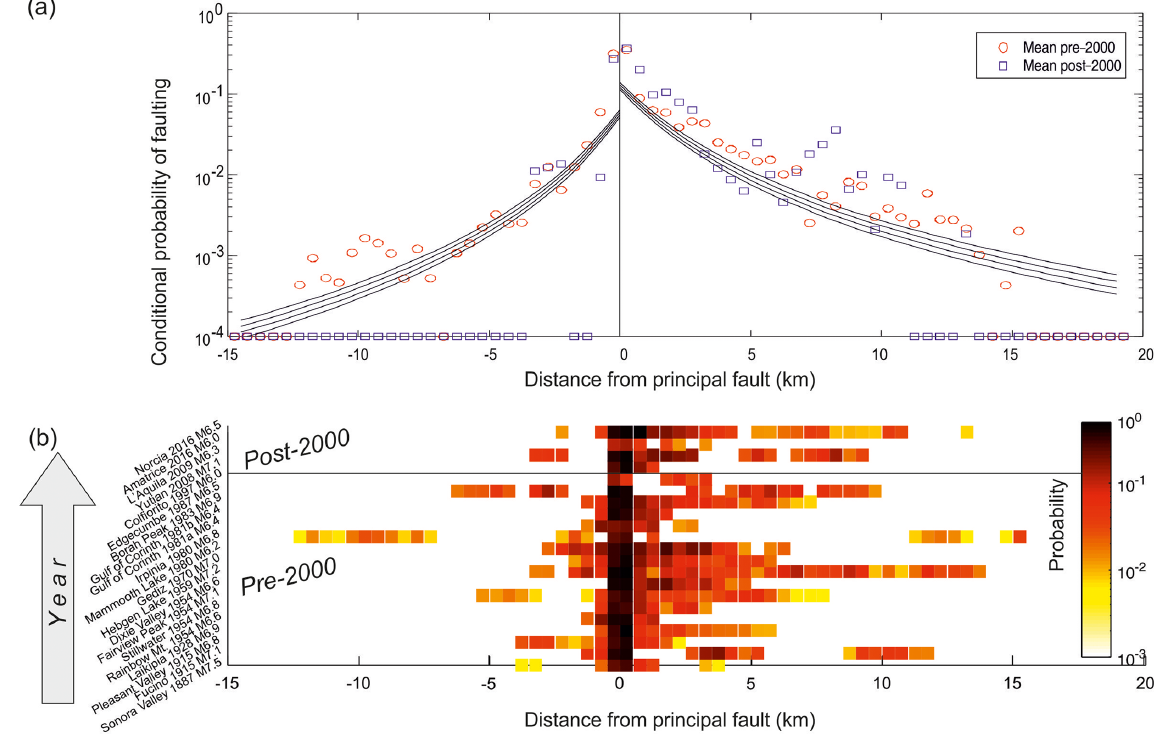
Figure 5. (a) Conditional probability of faulting for the 17 events that occurred before the year 2000 and the 4 events that occurred after 2000; colored symbols represent the mean values. Black lines are the scaling relations from Youngs et al. (2003; their Eq. 7). The “No data” field illustrates the region where no empirical observations are present, and probabilities are extrapolated by fitting. (b) Comparison between the 21 earthquakes, ranked according to the year of occurrence; each line represents a single